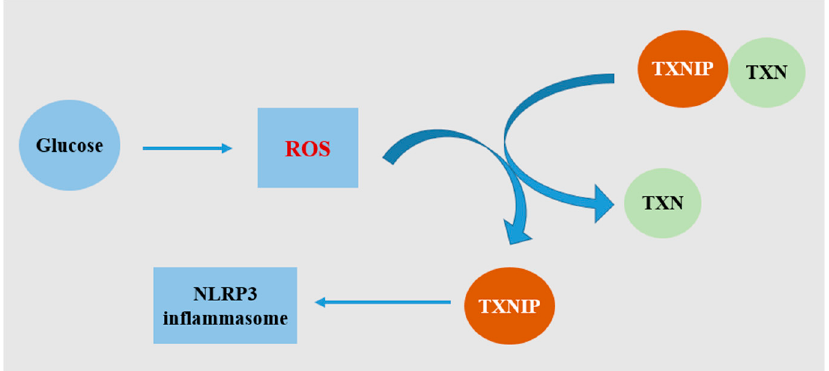
Figure 1. Schematic diagram of activation of the NLRP3 inflammasome by TXNIP under hyper- glycemia. Glucose stimulates excessive ROS generation. TXNIP usually binds and negatively regulates the activity of TXN (thioredoxin). Under stress, TXNIP is dissociated from TXN. TXNIP then binds NLRP3 directly, leading to assembly of the NLRP3 inflammasome.